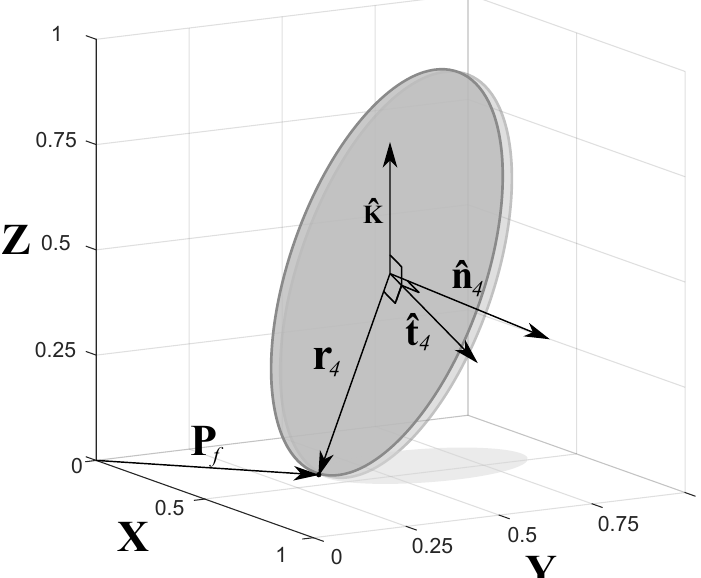
Figure 5. Cross-product approach. A vector formulation based on the fact that the vectors ˆn 4 , ˆt 4 , and r 4 are orthogonal to each